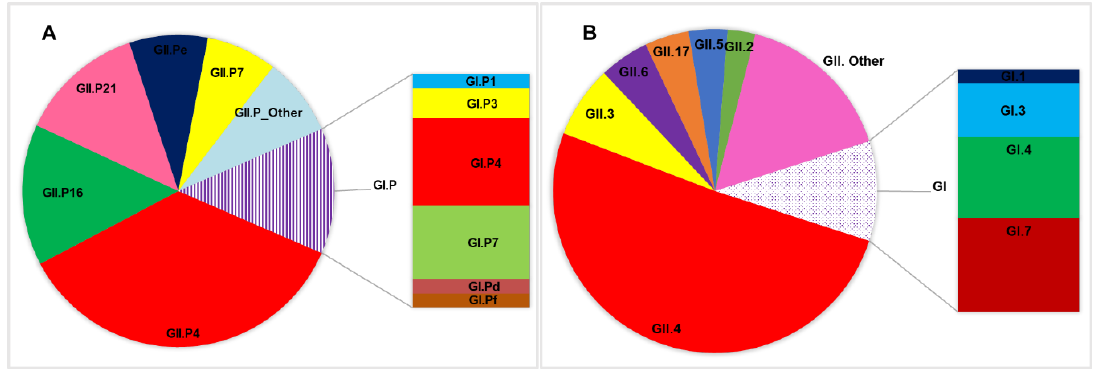
Figure 2. Distribution of the circulating polymerase ( A ) and capsid ( B ) genotypes in Ghanaian children between 2008 and 2017.